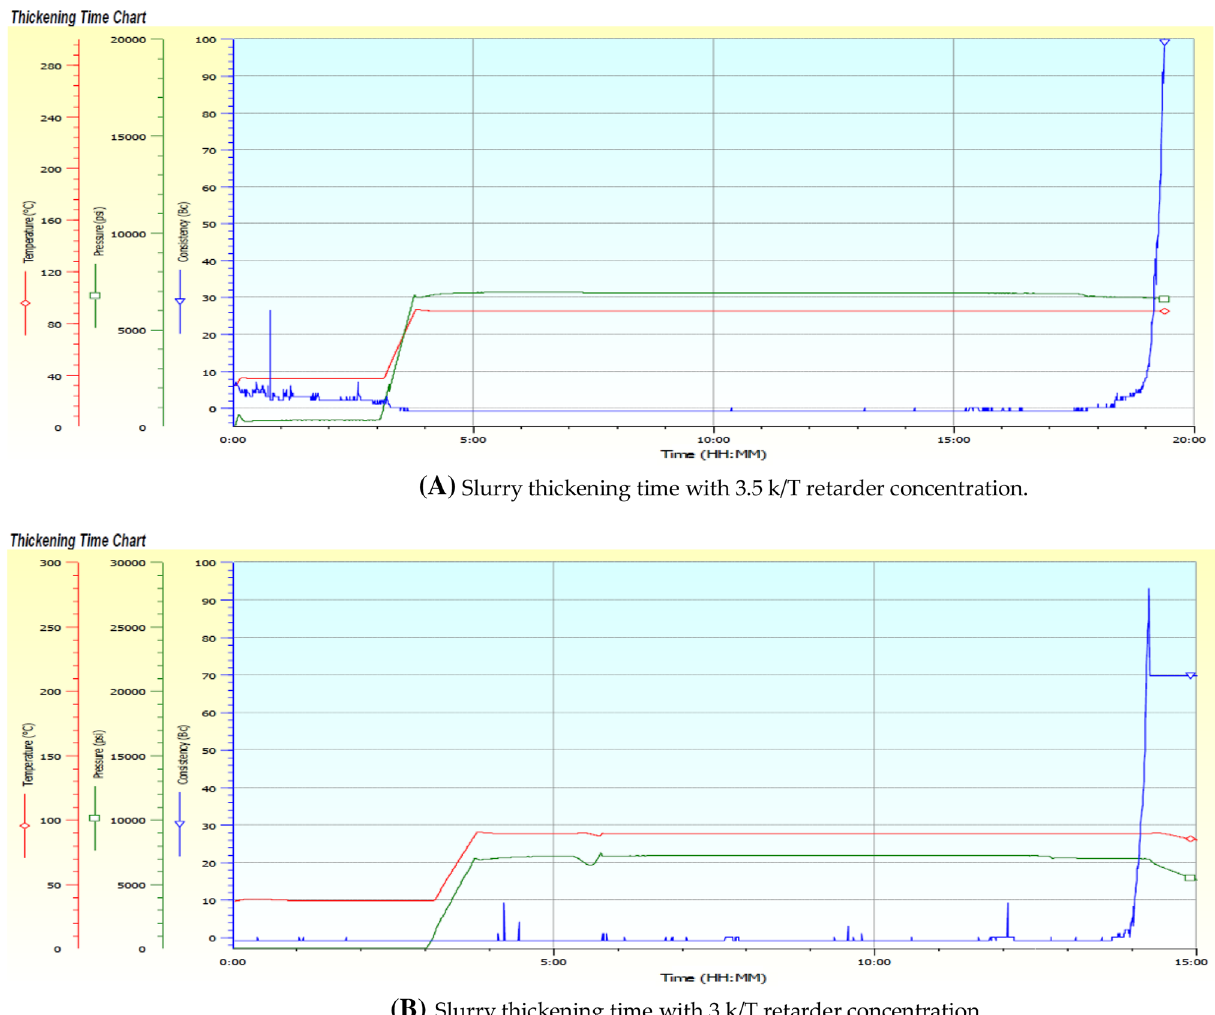
Fig. 2 Influences of variation in slurry retarder concentrations on the thickening